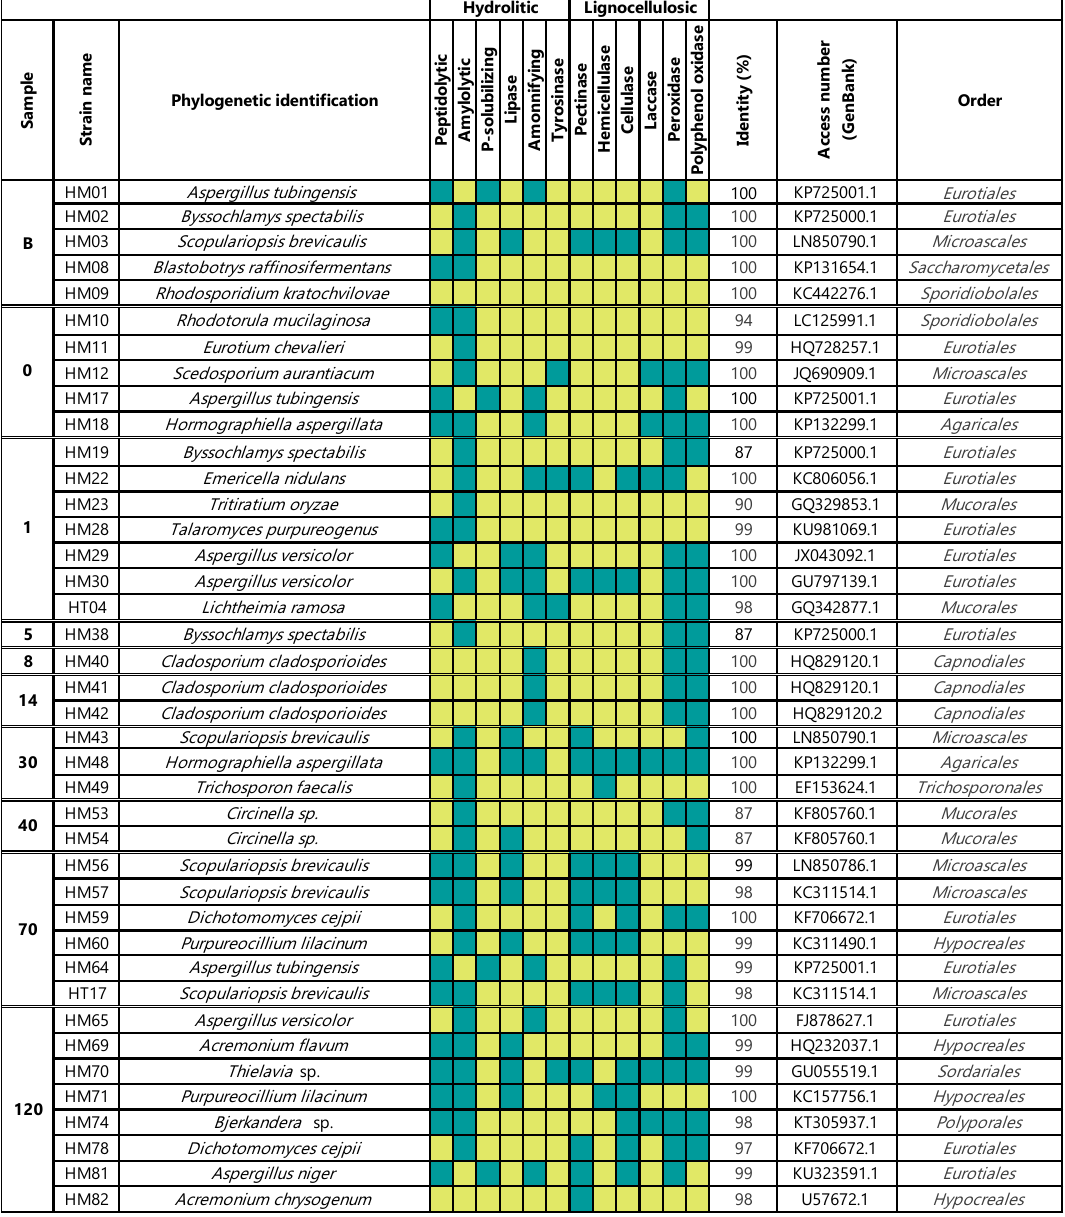
Figure 3. Heat map of the fungal isolates identified and the extracellular profile production for each isolate (blue: positive, yellow: negative). Identity (%): Percentage of nucleotide identity with the most similar GenBank sequence (Access. number (GenBank)) and order to which each sequence belongs.